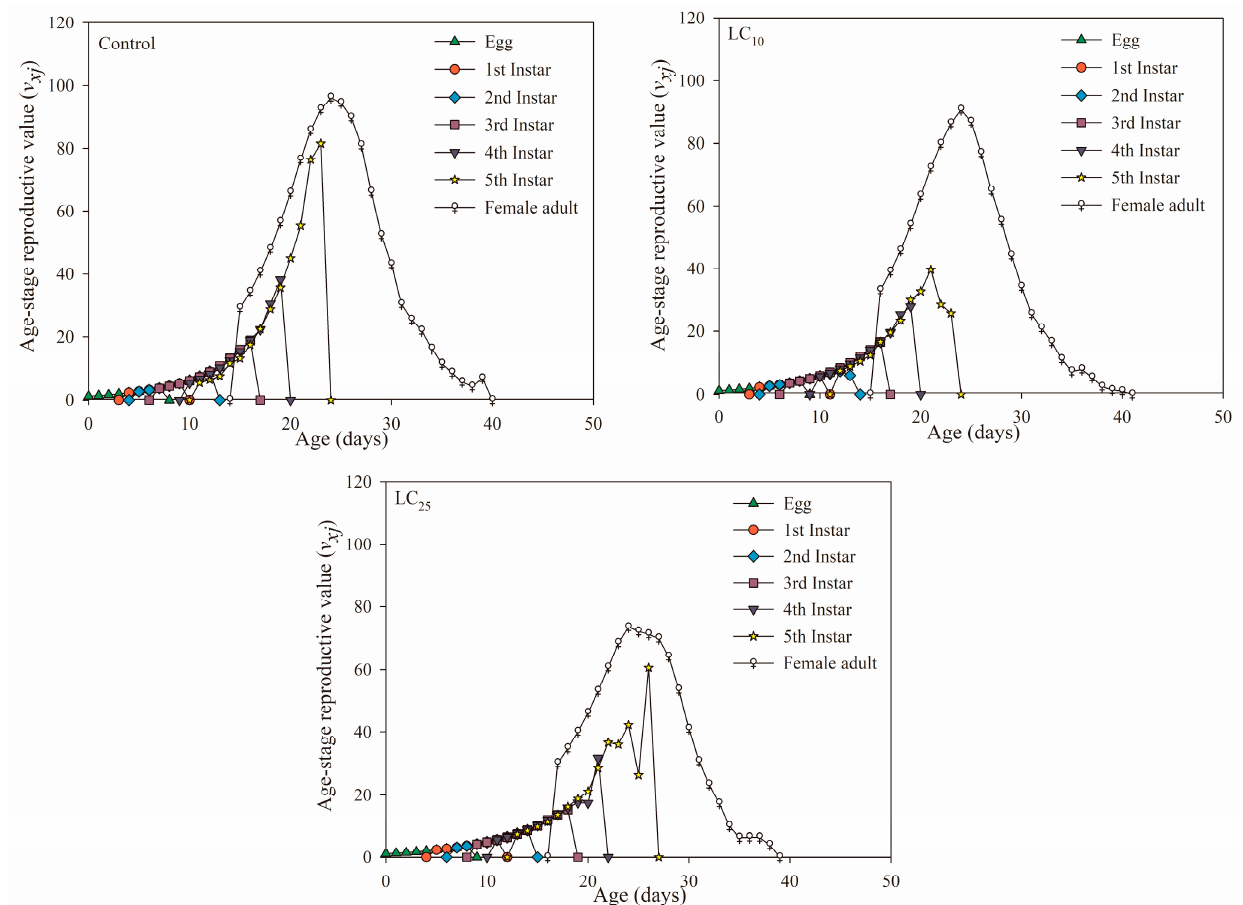
Figure 4. Age-stage reproductive value ( v xj ) in the control, Beauveria bassiana LC 10 - and LC 25 -treated F 1 generation of Sogatella furcifera .